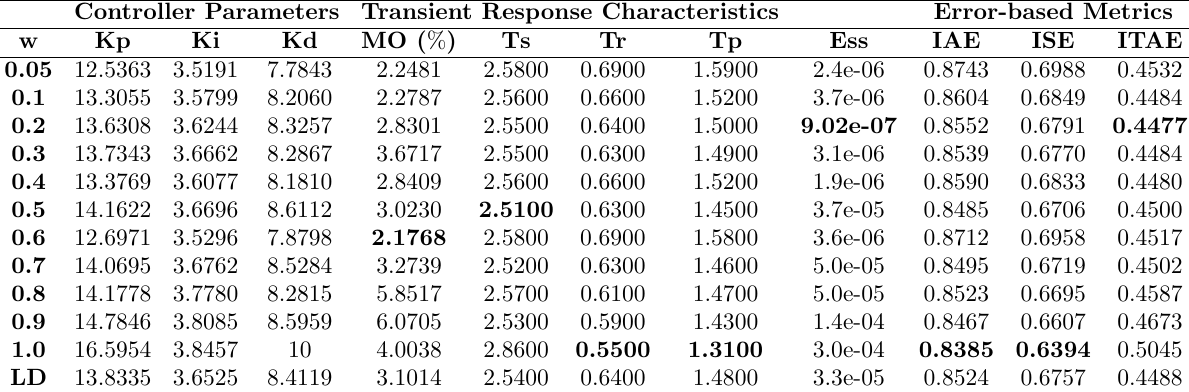
Table 2. Effect of inertia weight on system dynamic response, steady-state error and perfor- mance metrics.